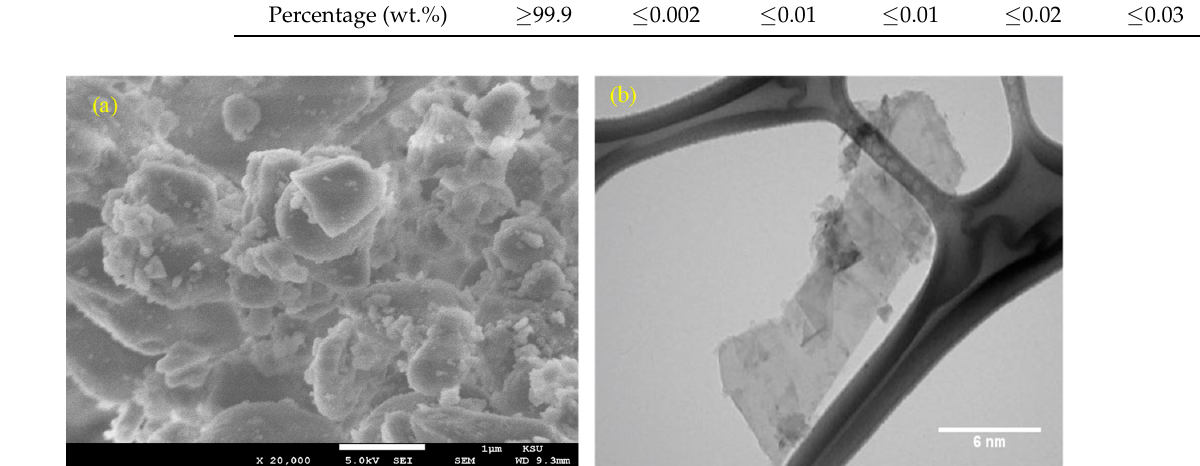
Figure 1. Morphology of the received powder. ( a ) Al 2 O 3 and GNPs; ( b ) GNPs (XG Sciences, Inc.,